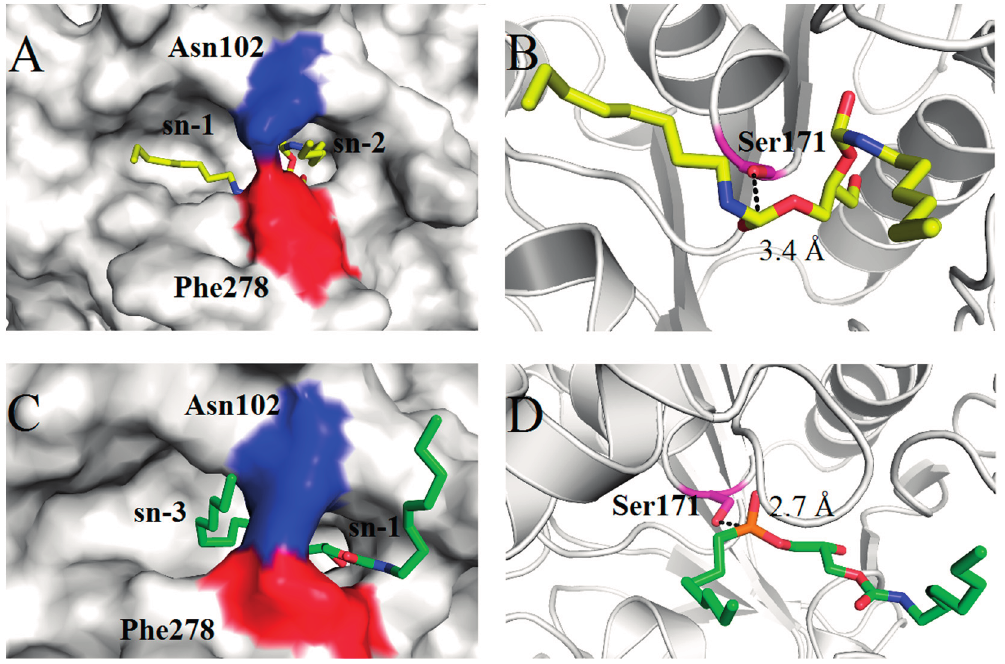
Figure 7. The 3-D structures of Mg MDL2-DAG analogue complexes. ( A ) Surface view of the optimized Mg MDL2-1, 2-DAG analogue; ( B ) A close-up view showing the distance from 1, 2-DAG analogue carboxyl carbon to O γ of Ser171 in Mg MDL2; ( C ) Surface view of the optimized Mg MDL2-1, 3-DAG analogue; ( D ) A close-up view showing the distance from 1, 3-DAG analogue phosphorus atom (substitution of carboxyl carbon) to O γ of Ser171 in Mg